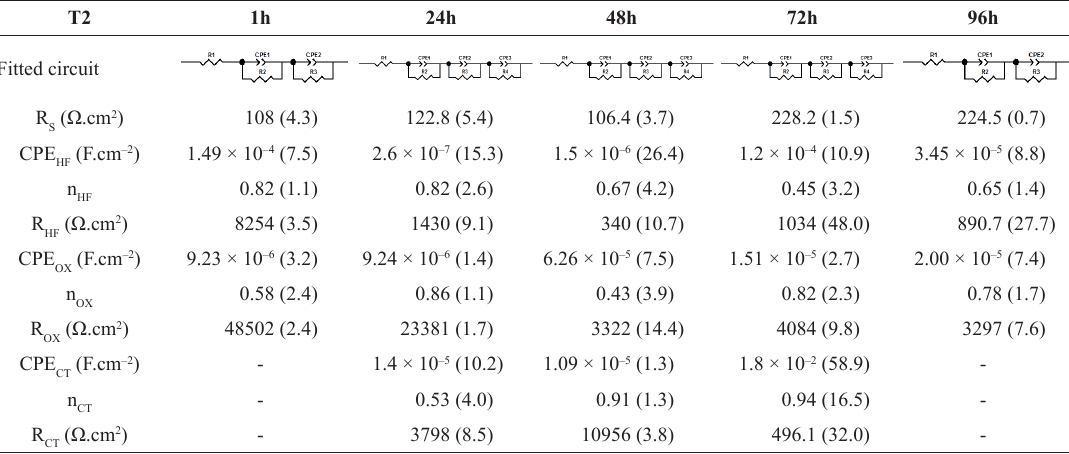
Table 7. Electrical elements fitted values for the T2 sample up to 96 hours of immersion in a 0.05 mol.L –1 NaCl solution. The error percentage associated with each parameter value is given in parenthesis.